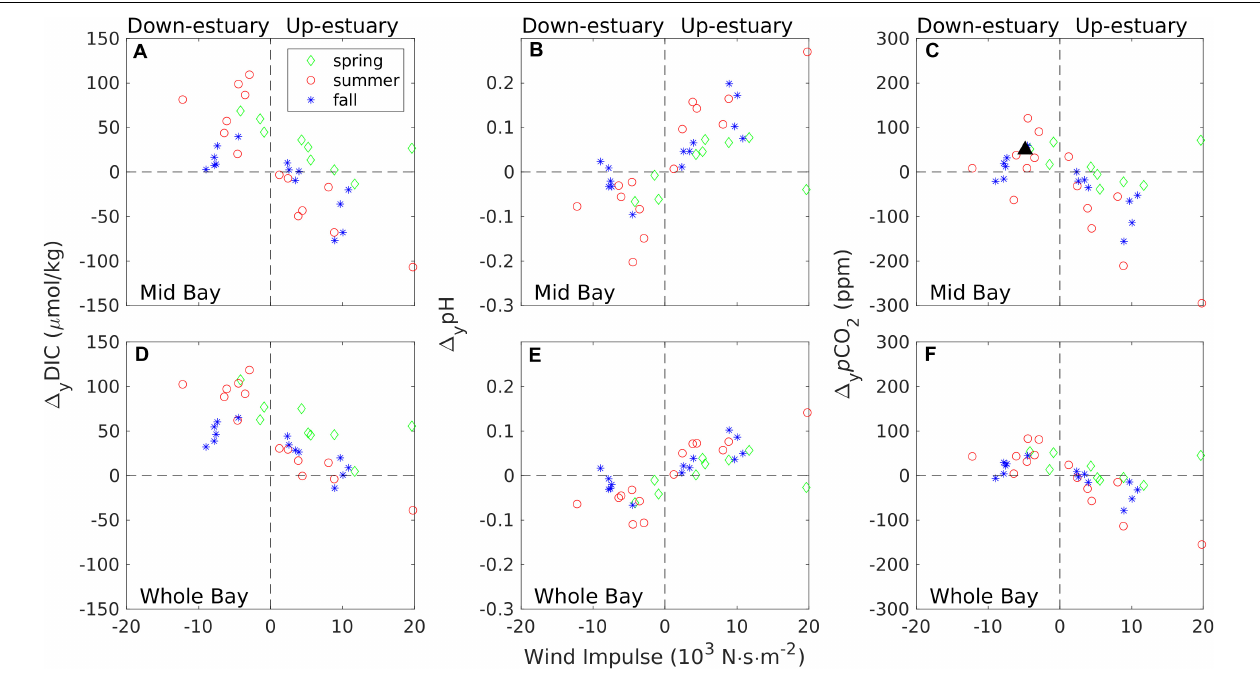
FIGURE 10 | Summary of wind effects on the lateral asymmetry in estuarine carbonate system. Time averaged lateral difference (eastern one third-minus western one third) in DIC (A,D) , pH (B,E) , and p CO 2 (C,F) in the mid-Bay region (top panel) or over the entire Bay (bottom panel) : spring (March–May, green diamonds), summer (June–August, red circles), fall (September–November, blue stars). The black triangle in (C) denoted the observational data from Huang et al.